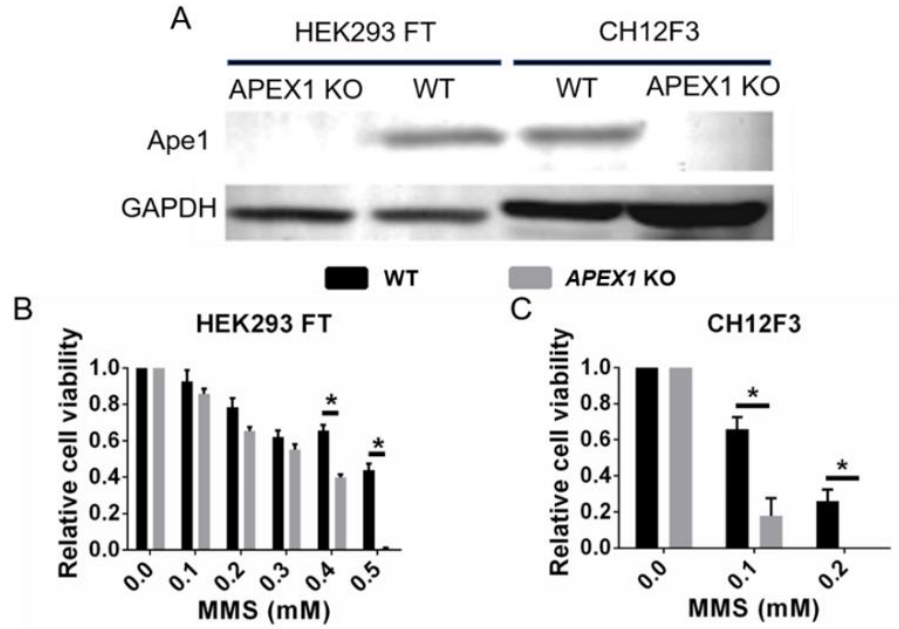
Figure 1. Ape1 deficiency sensitizes HEK293 FT and CH12F3 cells to methylmethane sulfonate (MMS). ( A ) Ape1 protein levels in HEK293 FT wild-type, HEK293 FT APEX1 -KO, CH12F3 wild-type, and CH12F3 APEX1 -KO cells. Cell viability of HEK293 FT wild-type and HEK293 FT APEX1 -KO ( B ) and CH12F3 wild-type and CH12F3 APEX1 -KO ( C ) cells after 24 h treatment with the indicated amount of MMS. Cell viability was determined using the MTT assay. * p < 0.01. Data are presented as the mean ± SD, with n = 4 per group, and analyzed by Student t